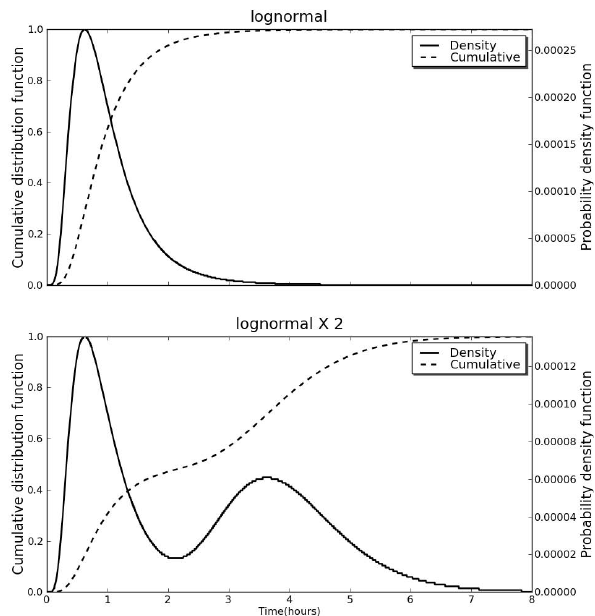
Fig. 1. VSEM uses lognormal distributions to simulate the process of incorporation of the population into the evacuation process. Peo- ple joined in the evacuation flux are represented by the black line and people arrived to check or exit point is represented by a dashed line. A single distribution implies that the whole population reacts in the same way. A superposition of several different lognormal dis- tributions simulates the behaviour of the various subgroups existing inside the threatened population due to its age, economic level,